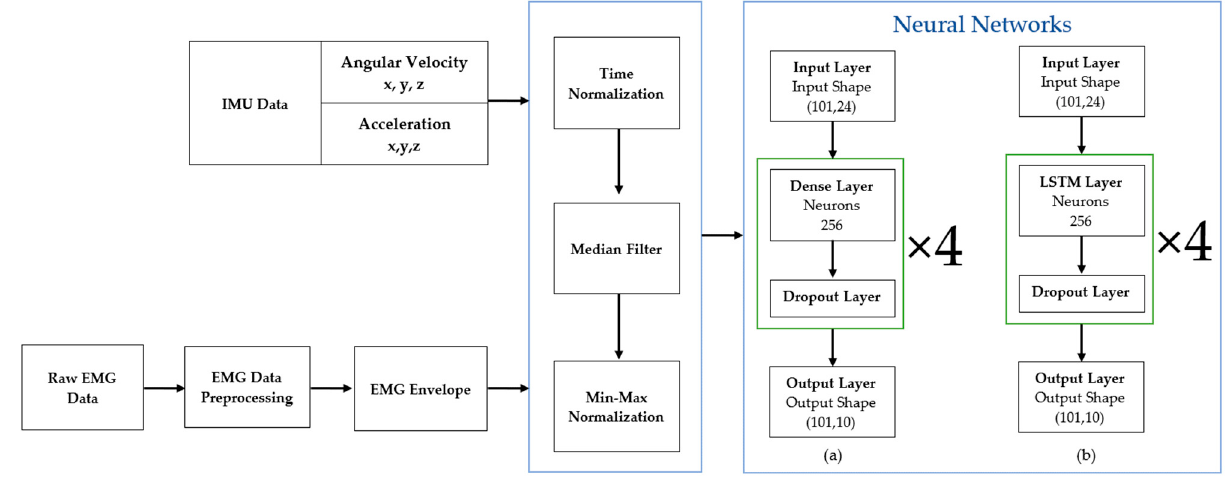
Figure 3. Data pre-processing and the neural network architectures of ( a ) FNN ( b ) LSTM models. FNN and LSTM use the same ‘tanh’ as the activation function in the hidden layers. They use the same ‘sigmoid’ as the output layer activation function. Both models used Mean Square Error (MSE) as the loss function and were optimized using Adam optimizer.